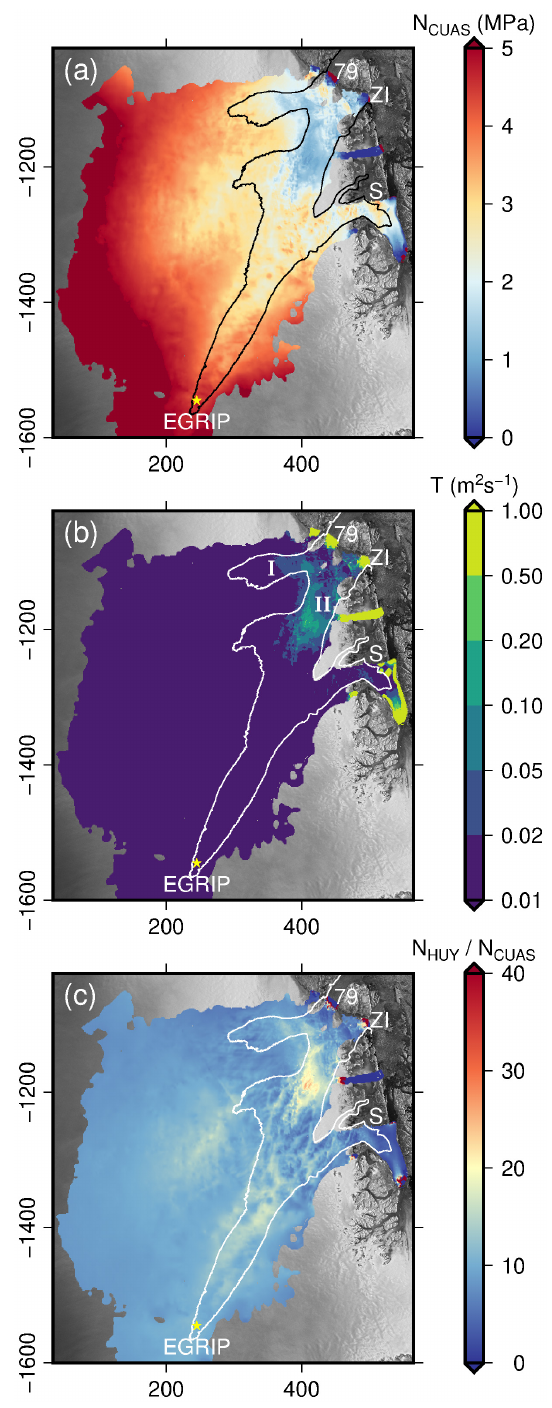
Figure 8. Results for the NEGIS region with forcing due to basal melt (PISM) representing winter conditions. White lines indicate the 50ma − 1 velocity contour. Panel (a) shows the effective pressure N CUAS , panel (b) shows the transmissivity T (logarithmic scale), and panel (c) shows the quotient of the ice overburden pressure above flotation and the effective pressure computed by